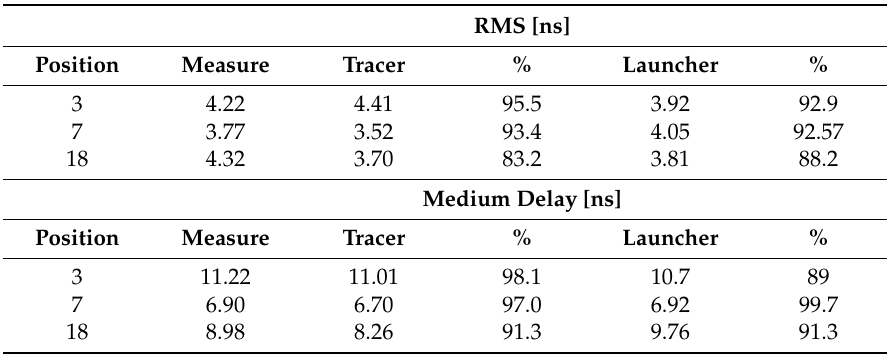
Figure 5. Comparison between the power delay profile (PDP) measured in Position 3, simulated with the tracer and simulated with the launcher programmed in the GPU. Table 2. Measured and simulated